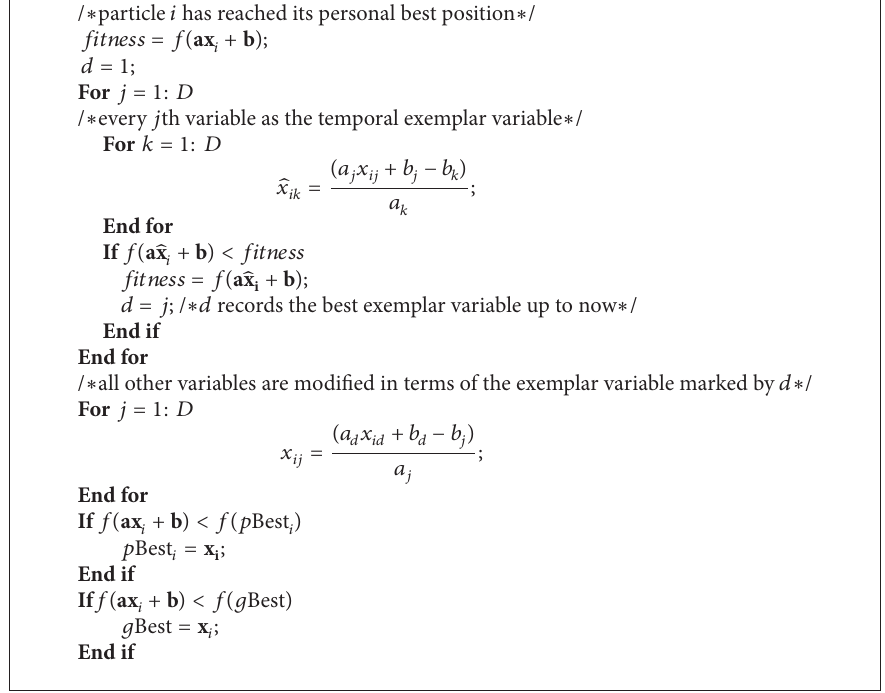
Algorithm 1: InnerVariableLearning( 𝑖